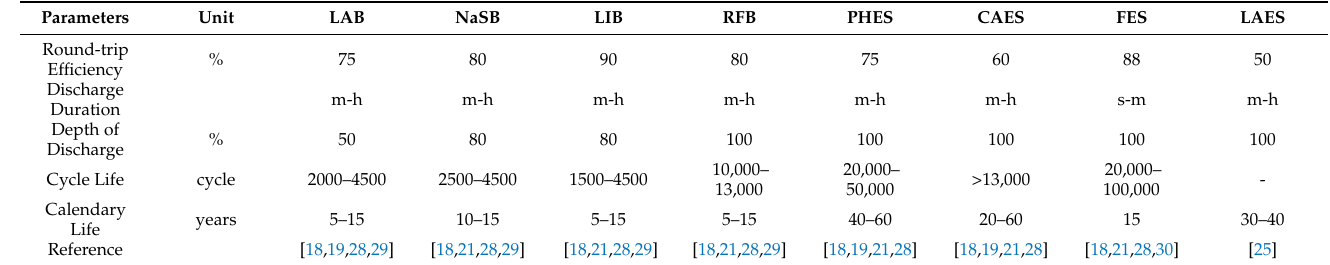
Table 1. Electrical Storage System (ESS)